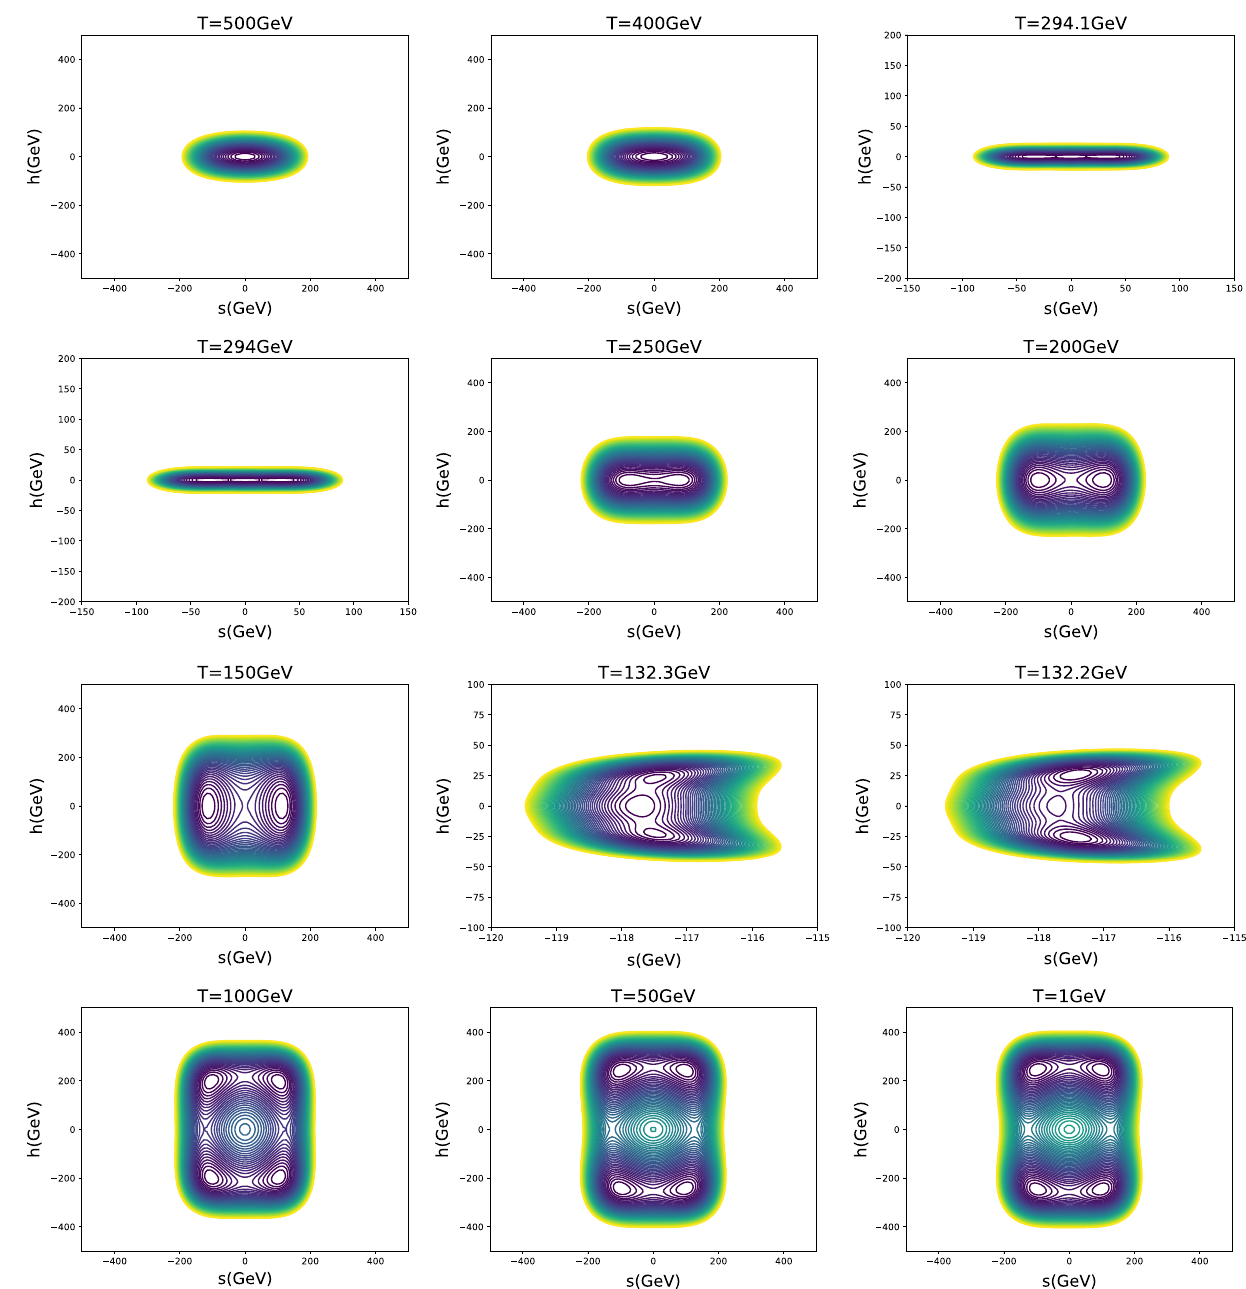
v = 100 GeV, λ = 0 . 5, λ = 0 . 12, λ = 0 . 1012, g = 0 . 2. BL s h sh Here, the s -direction PT happens at temperature T (cid:4) 294 . 06 GeV, the hybrid PT along the mixing direction happens at T (cid:4) 132 . 23